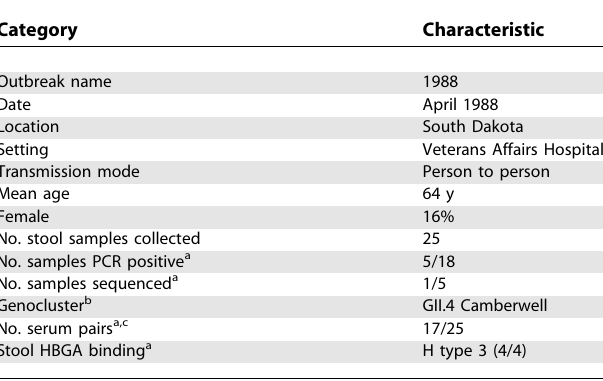
Table 1. Characteristics of the GII.4 Outbreak Represented by the Samples Used in This